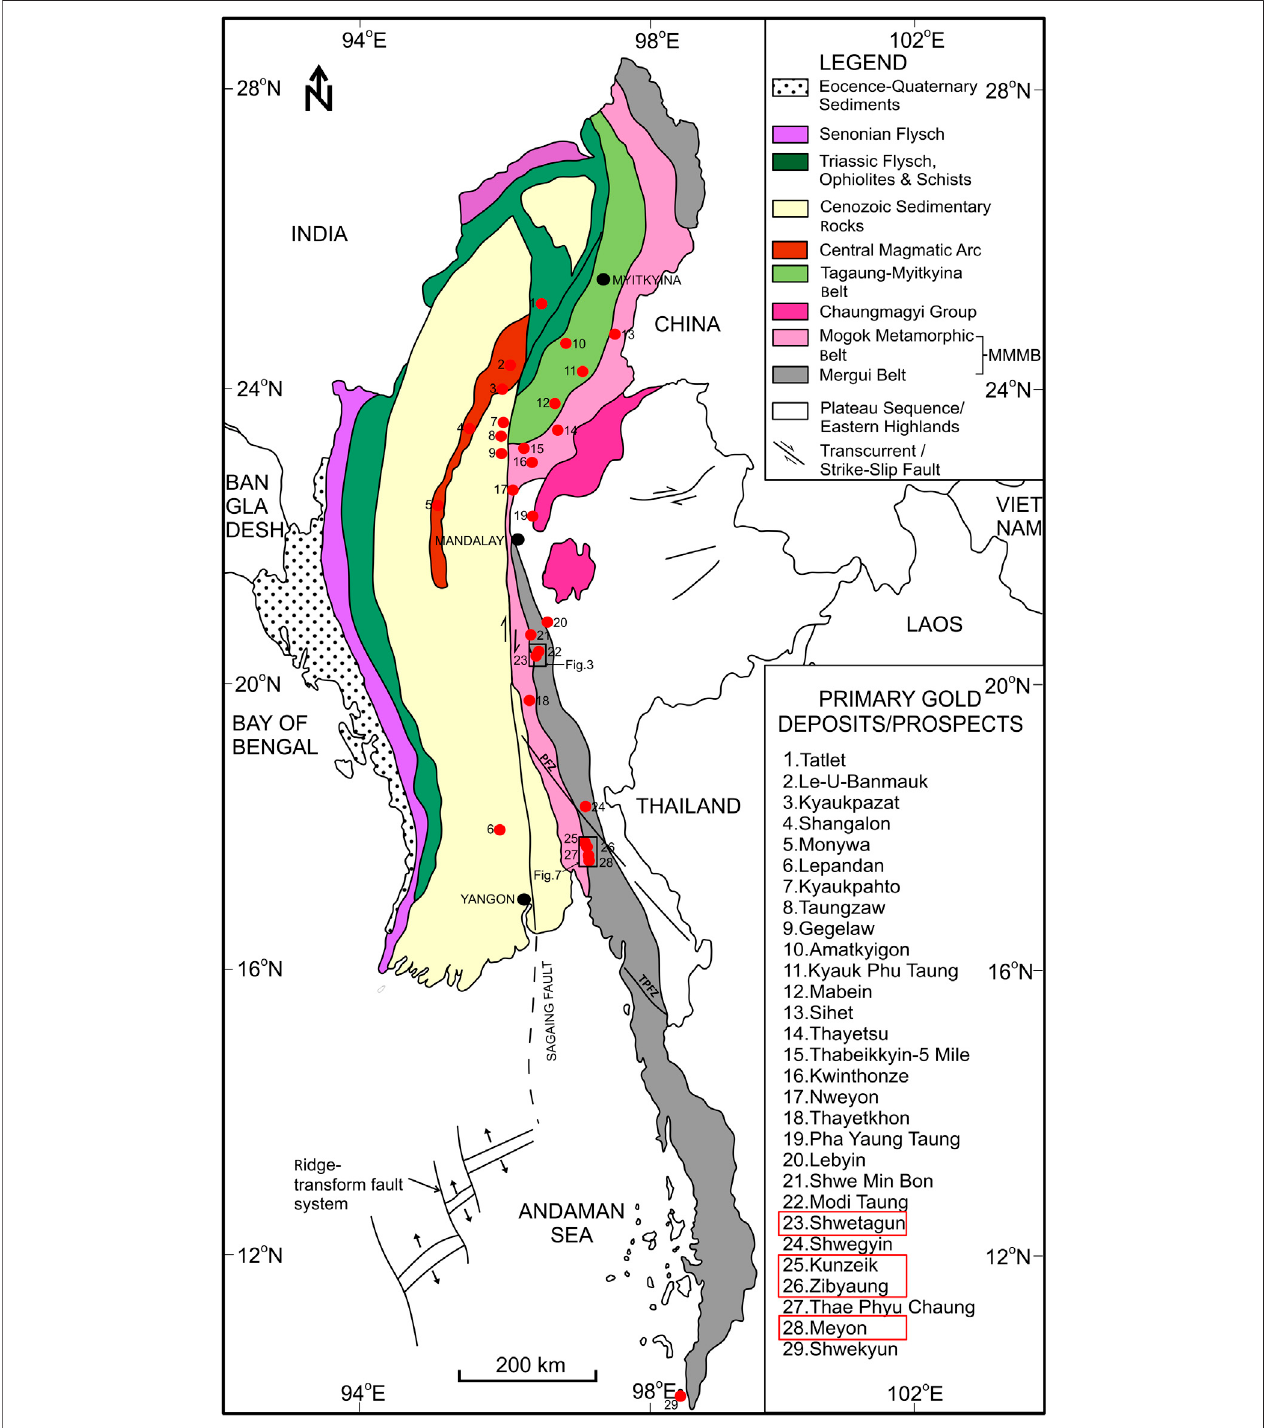
FIGURE 1 | Major structural belts, and gold occurrences in Myanmar (Modi fi ed after Mitchell et al., 2004; Ye Min Swe et al., 2017; Myo Kyaw Hlaing et al., 2019), PFZ, Papun Fault Zone; TPFZ, Three Pagodas Pass Fault Zone; MMMB, Mogok-Mandalay-Mergui Belt.